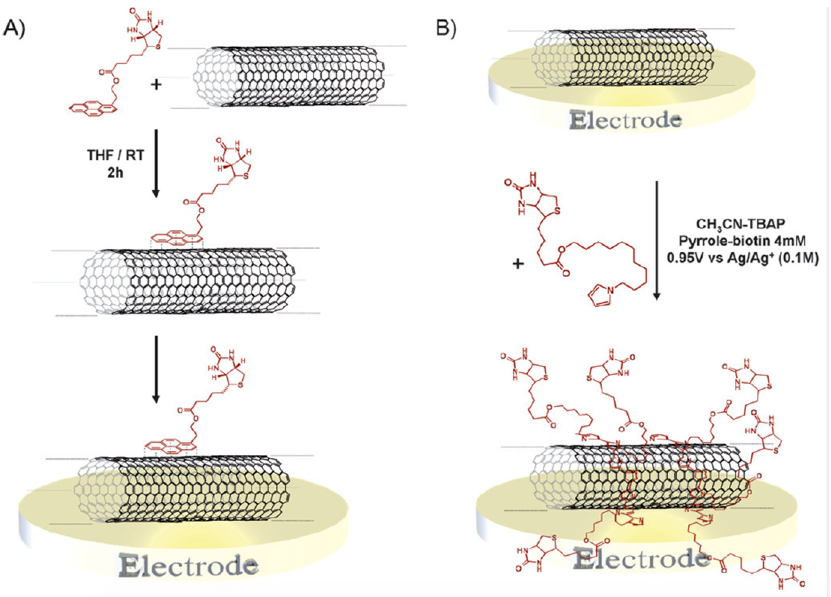
Figure 12. Biotin functionalization on nanotubes using ( A ) π - π stacking interaction between pyrene-biotin derivatives and the nanotube side walls; ( B ) Electropolymerization of the pyrrole-biotin monomer on the SWCNT [124].